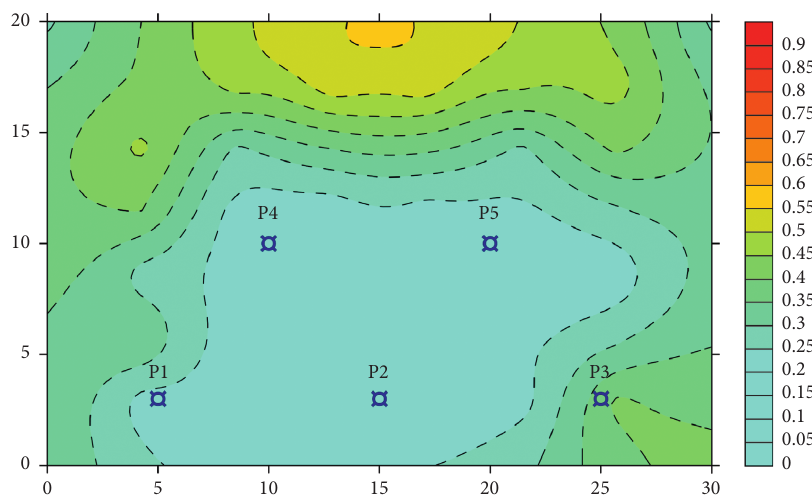
Figure 6: Remaining oil saturation distribution of binary flooding with no edge water.